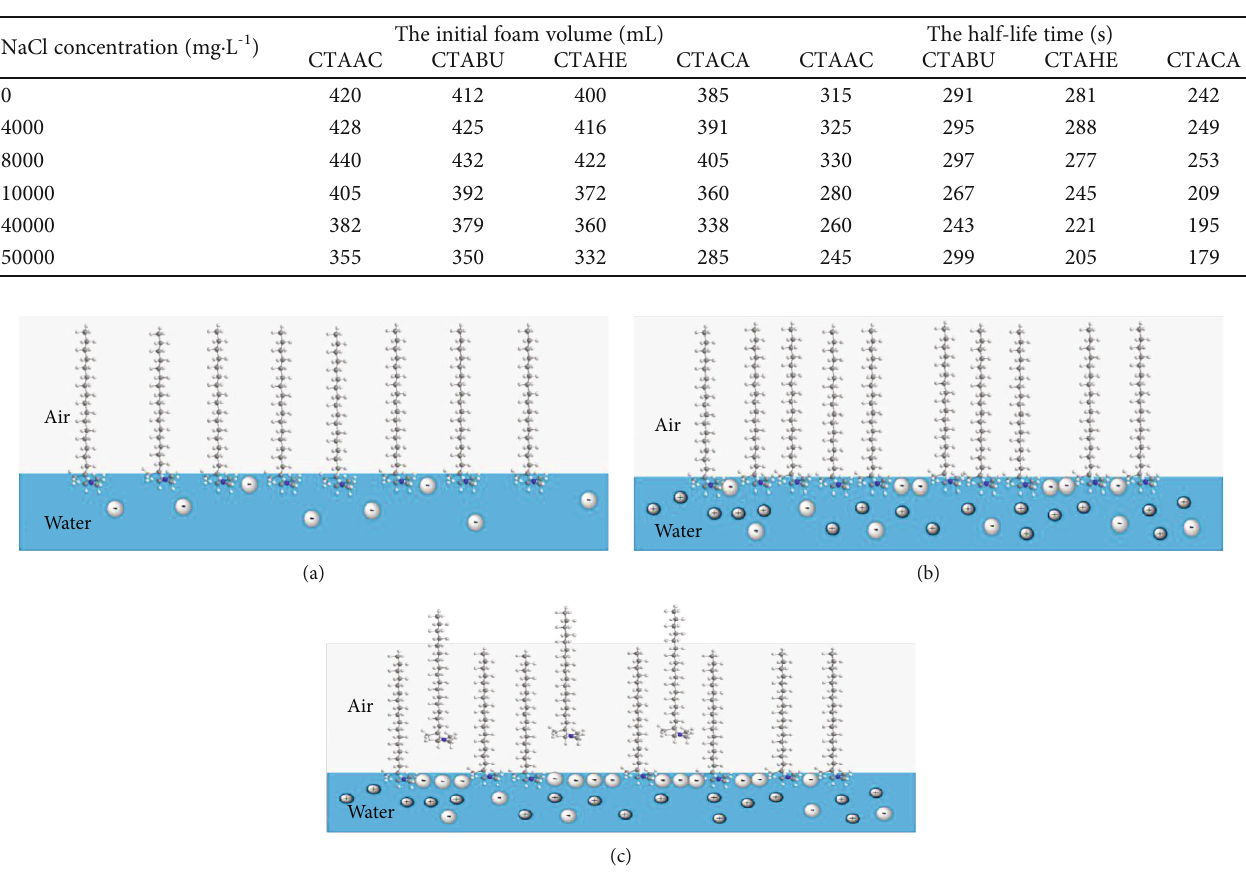
Figure 6: Schematic representation of di ff erent